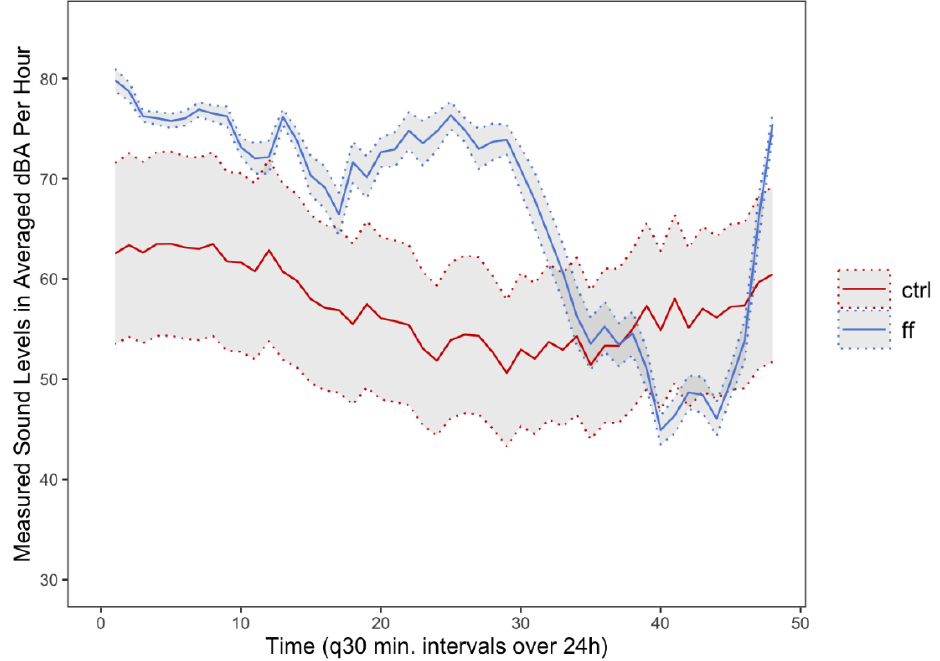
Figure 1. For both groups (firefighters [blue] and controls [red]), the mean was calculated at each interval (every 30 min for each 24 h shift) recorded and extracted from the Apple Watch. The grey cloud is the standard error margin for each time point. Generally, the measured sound levels experienced by firefighters were higher than those experienced by controls with less variability across recorded intervals. Table 5. Noise metrics for firefighters and controls.